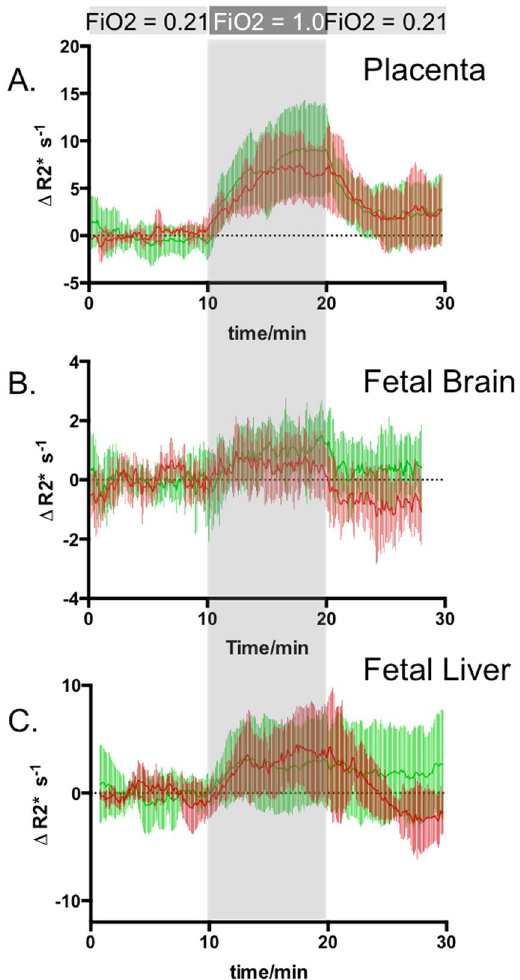
Figure 5. Time activity curves of placentas and fetal organs presented as signal intensity change relative to baseline ( Δ R2 * ). Green: mean and standard deviation of Δ R2 * for the organs of AGA fetuses; Red: mean and standard deviation of Δ R2 * for the organs of SGA fetuses as defined retrospectively using birth weight. ( A ) placentas, ( B ) fetal livers, ( C ) fetal